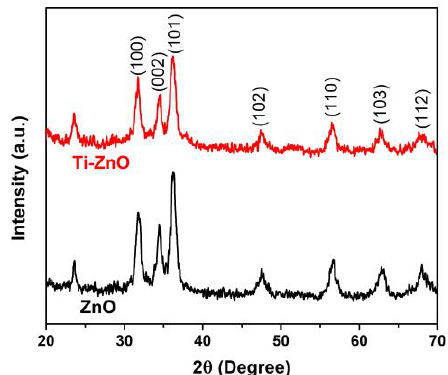
Figure 5. XRD patterns of ZnO and Ti-ZnO NPs.